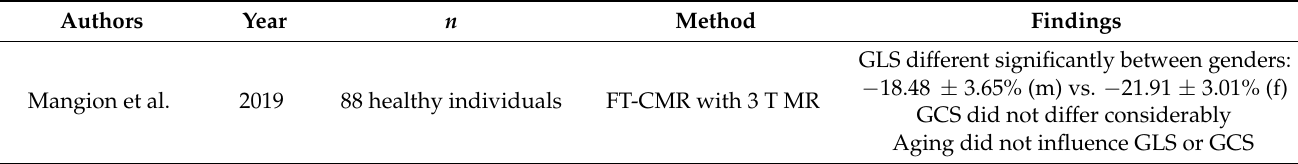
Table 2. LV myocardial strain variations in normal individuals